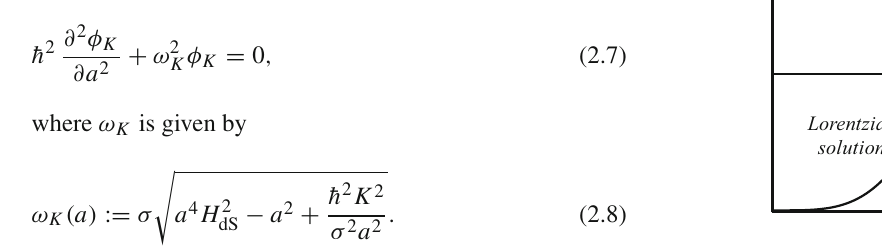
Fig. 1 The tunnelling potential V ( a ) = σ 2 ( a 4 − H 2